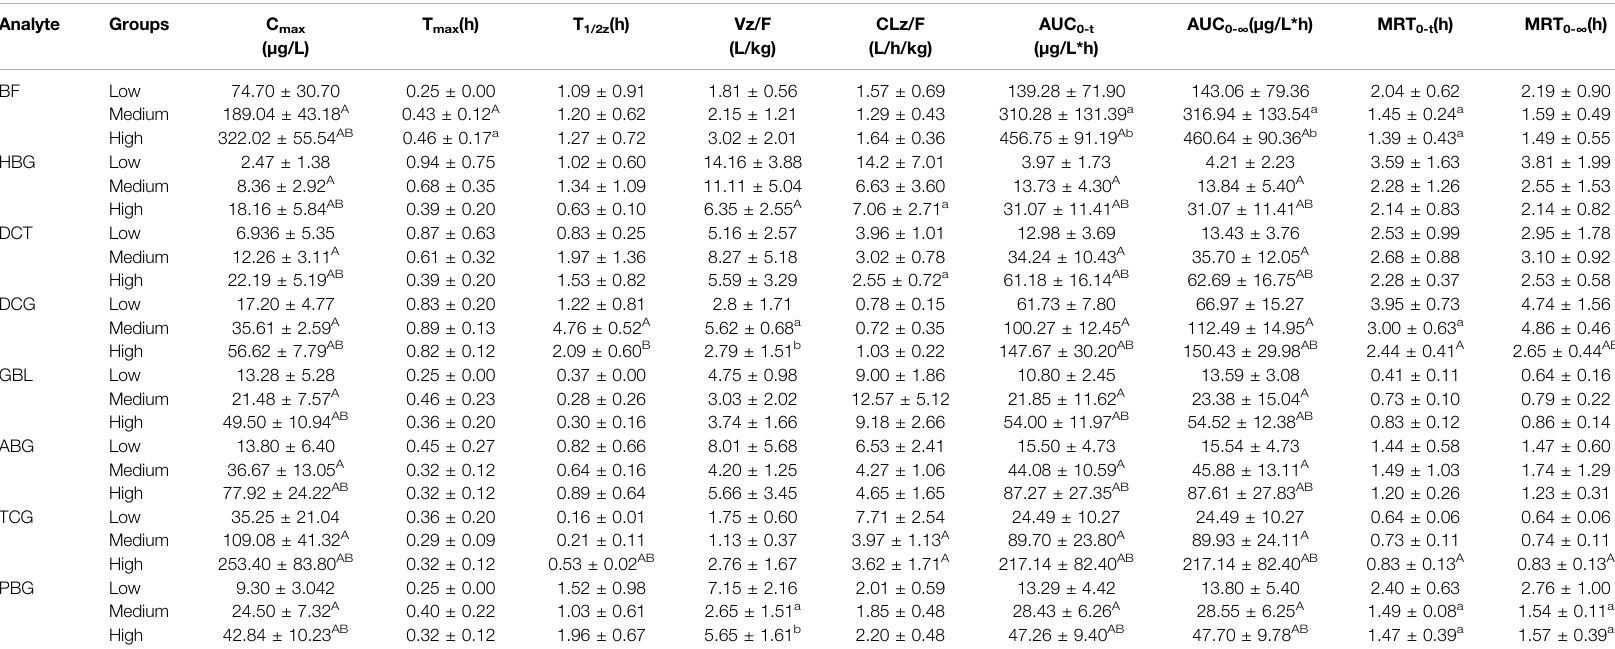
TABLE 5 | Pharmacokinetic parameters of the target analytes after the oral administration of cinobufacini capsule (0.9, 1.8, and 3.6 g/kg) and intravenous administration of cinobufacini injection at a dose of 9 ml/kg to male SD rats (mean ± SD, n = 6). Analyte Groups